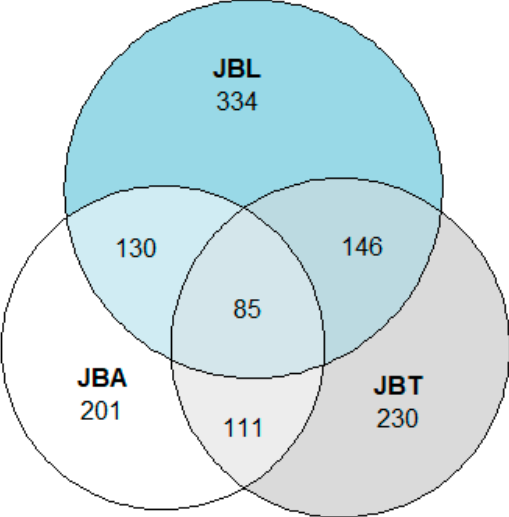
Figure 2. Euler diagram showing the number of taxa of the three Botanical Gardens of Lisbon (JBA, JBL, JBT). The overlapping shapes represent taxa existing in two or three of the gardens. Table 1. Taxa found in the arboreal stratum of the three Botanical Gardens of Lisbon (JBA—Botanical Garden of Ajuda; JBL—Lisbon Botanical Garden; and JBT—Tropical Botanical Garden) in 2021: family, scientific name, occurrence, habit and native distribution.